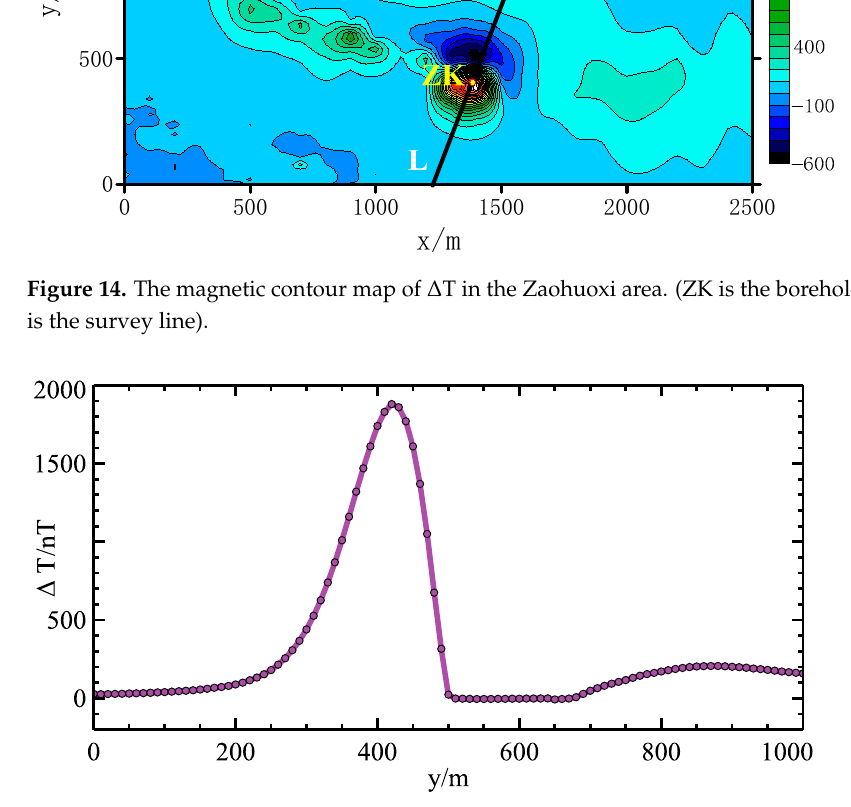
Figure 15. The magnetic anomaly of line L.